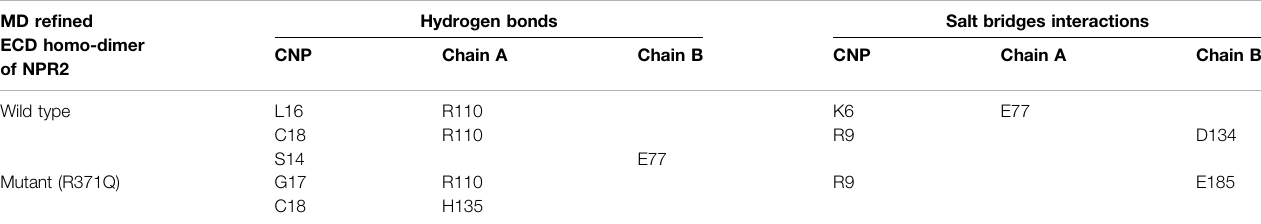
TABLE 2 | Molecular interactions between CNP and the MD re fi ned ECD homo-dimer of NPR2. MD re fi ned ECD homo-dimer of